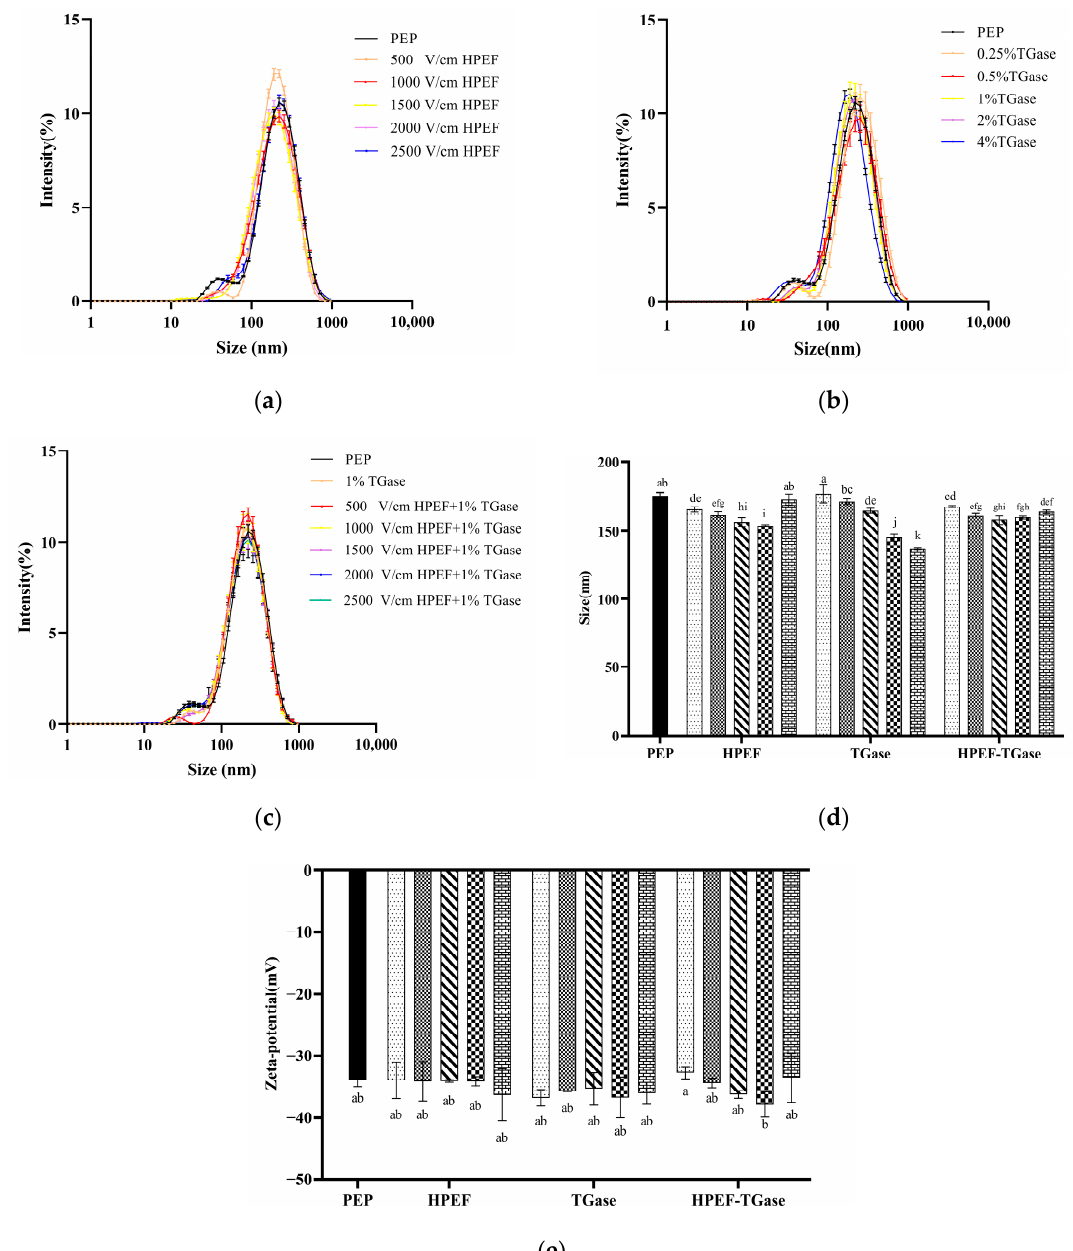
Figure 4. The effects of HPEF (500, 1000, 1500, 2000, and 2500 V/cm) addition, TGase (0.25, 0.5, 1, 2, and 4%), and compound treatment (HPEF-500, 1000, 1500, 2000, 2500 V/cm; 1% TGase) on the particle size distribution, average particle size, and Zeta-potential of PEP. Note: ( a ), particle size distribution curves of PEP after HPEF treatment; ( b ), particle size distribution curves of PEP after TGase treatment; ( c ), particle size distribution curves of PEP after HPEF + TGase treatment; ( d ), average particle size; ( e ), Zeta-potential. The different lowercase letters indicate a significant difference between groups ( p < 0.05).